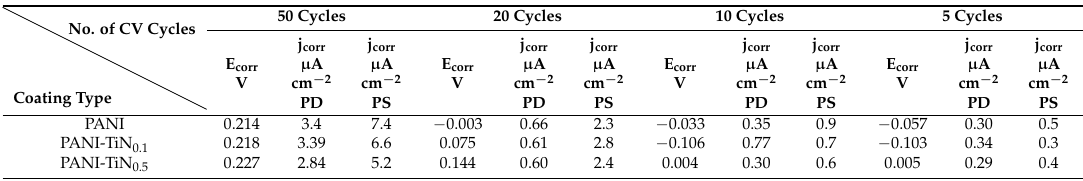
Table 2. The corrosion potentials and corrosion currents recorded at 1.0 V SHE for all coatings with changes in TiN loading and coating